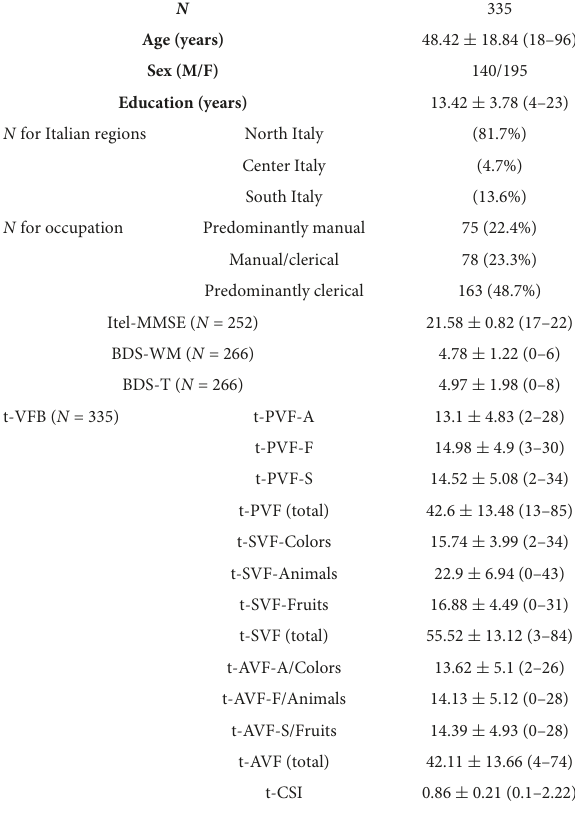
TABLE 2 Demographic and cognitive data of the normative